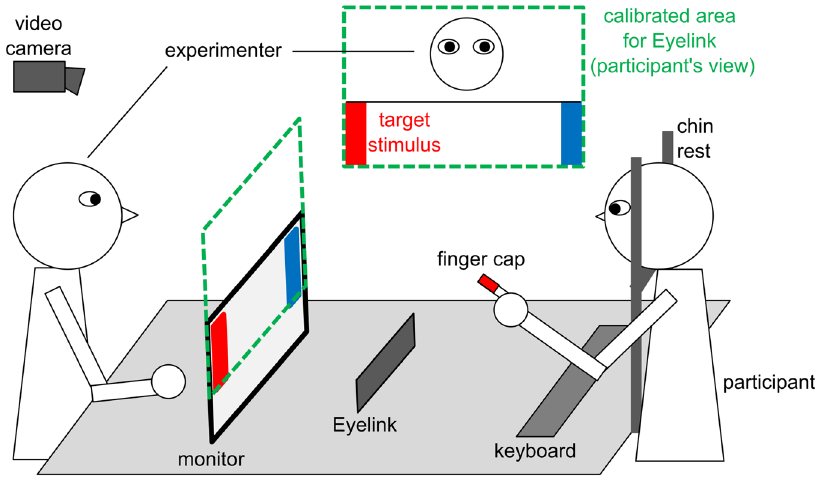
Figure 1. Schematic display of the experimental task setup during free task version and nonverbal task version. The experimenter was the designated interaction partner during the tasks and sat opposite of the participants. A monitor facing the participants displayed the stimuli. An Eyelink recorded participants’ eye movements, and the calibrated area included the interaction partner’s facial area and the stimuli. In the free task version, participants were free to choose how to convey the spatial information of the target stimulus to the partner. In the nonverbal task version, participants were instructed to press the space bar of a keyboard located in front of them and release it only for the pointing gesture. A video camera recorded all test runs, and the colored finger caps that participants wore on their index fingers were used to later extract the movement trajectories (see “Video